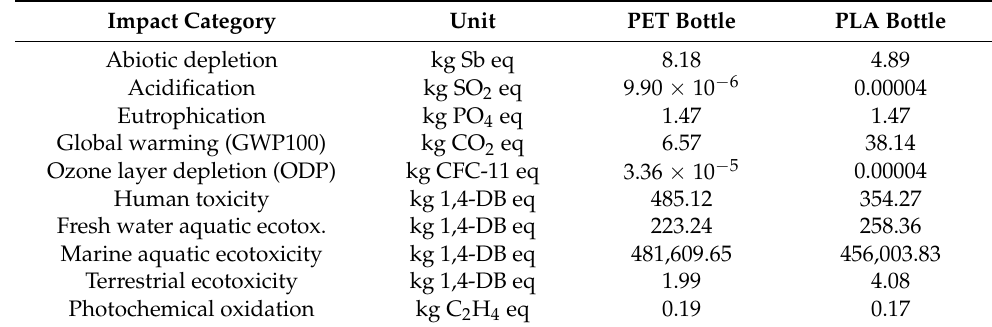
Table 2. The total impact of the production of bottles on the